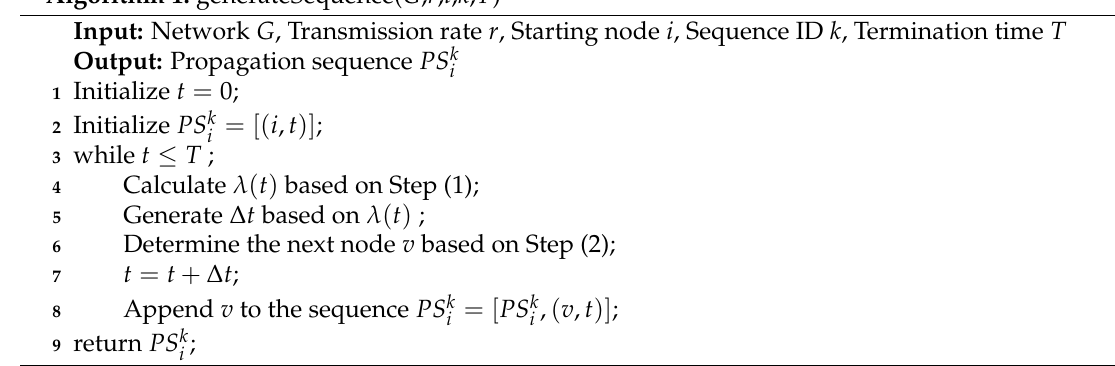
Algorithm 1: generateSequence( G , r , i , k , T